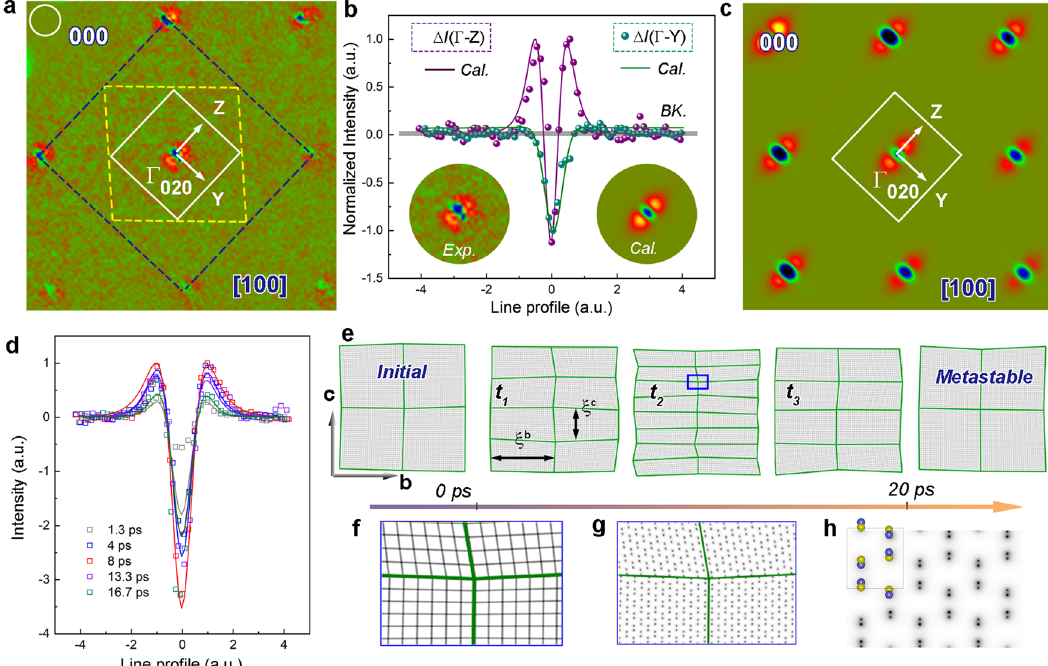
Fig. 2 Photoinduced domain evolution observed in UED patterns. a An intensity difference map between the UED patterns taken before time-zero and at 1.7 ps. The Brillouin zones around the (020) Bragg peak ( Γ point) with the 1st, 2nd, and 3rd Brillouin zone boundaries marked by white, yellow and black lines, respectively. The (000) beam position is indicated by the circle. b The dots present the line pro fi les of the diffraction intensity along the Γ – Z (purple dots) and Γ – Y directions (green dots) in a , showing signi fi cant asymmetry of the intensity pro fi les. The solid lines are the intensity pro fi les from the simulated pattern in c . c Simulated intensity difference map calculated using Monte Carlo based multislice method with large supercell containing domain structure between t ≤ 0 (initial) and t > 0. d Line pro fi les along Γ -Z direction of the Bragg peak in the UED intensity difference pattern as a function of time. The squares are experimental data, the solid lines are simulation result. e Schematic of the domain formation and evolution after photoexcitation, showing the change of domain size ( ξ c ) along the c direction with time, while the domain size ( ξ b ) along the b direction remains unchanged. The domain size in b and c directions becomes equal in the metastable state. f Magni fi ed drawing from the area marked by the blue rectangle in e , showing lattice distortion after forming domains. g Projected potential calculated based on the distorted lattice in f . The lattice distortion is exaggerated for clarity in e – g . h [100] projected electric potential calculated from the undistorted SnSe structure. The [100] projection of SnSe structure model is embedded with blue and yellow spheres representing Sn and Se,